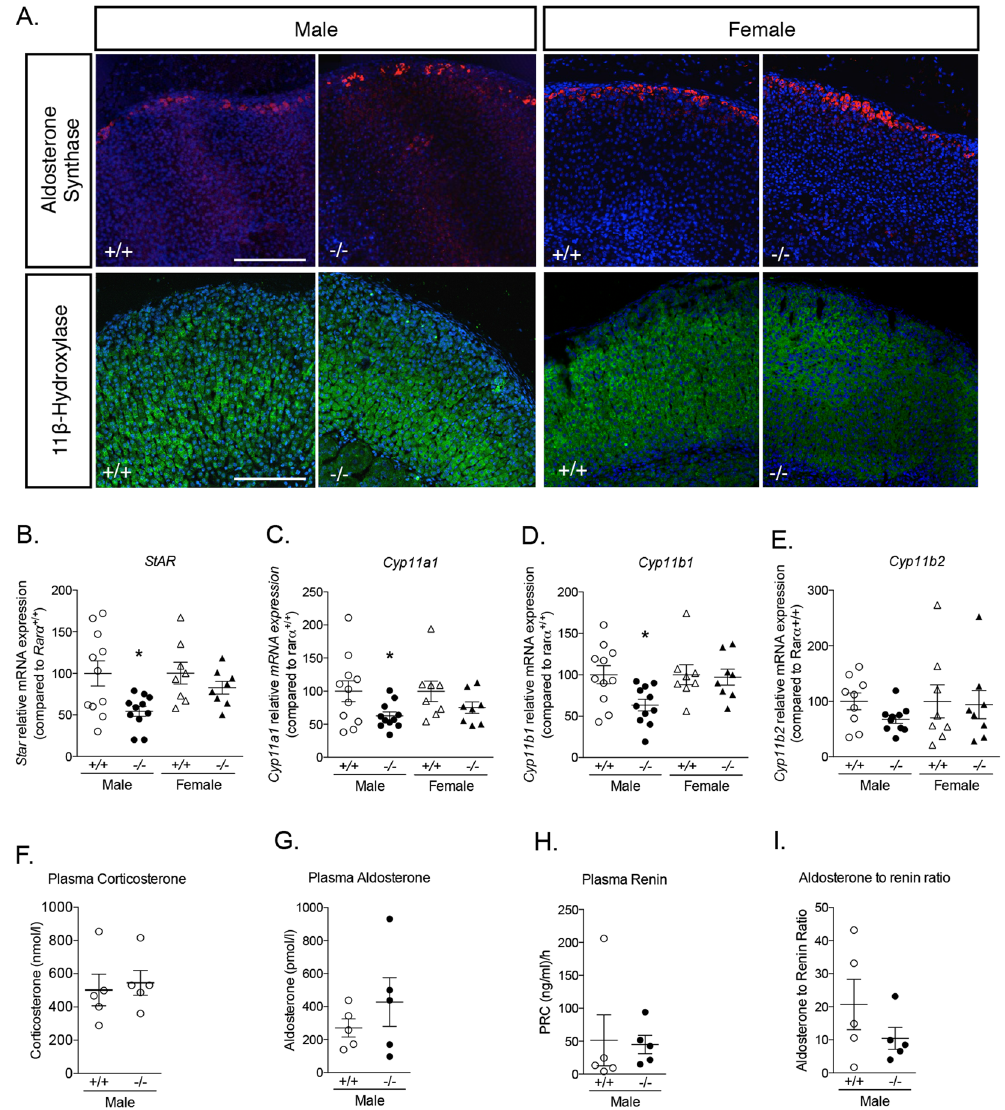
Figure 3. Impact of Rar α inactivation on adrenal steroidogenesis. (A) Expression of aldosterone synthase and 11 β -hydroxylase in 12 weeks old male and female Rar α + / + and Rar α - / - mice. ( B – F ) Expression of steroidogenic genes in male and female Rar α + / + and Rar α - / - mice. mRNA expression of Star ( B ), Cyp11a1 ( C ), Cyp11b1 ( D ) and Cyp11b2 ( E ) was assessed by RT-qPCR. RT-qPCR were performed on mRNA extracted from 6–11 adrenals from 12 weeks old male and female Rar α + / + and Rar α - / - mice. ( F , G ) Measure of plasma aldosterone ( F ) and corticosterone ( G ) concentration by mass spectrometry in male mice. ( H , I ) Plasma renin concentration (PRC) ( H ) and aldosterone to renin ratio ( I ). Measure of plasma aldosterone, plasma corticosterone and plasma renin were done on 5–6 animals per group. Values are presented as the mean ± SEM; p values were calculated using a Mann-Whitney test or t -test. For correlation, Pearson calculations were performed. * p < 0.05; ** p <